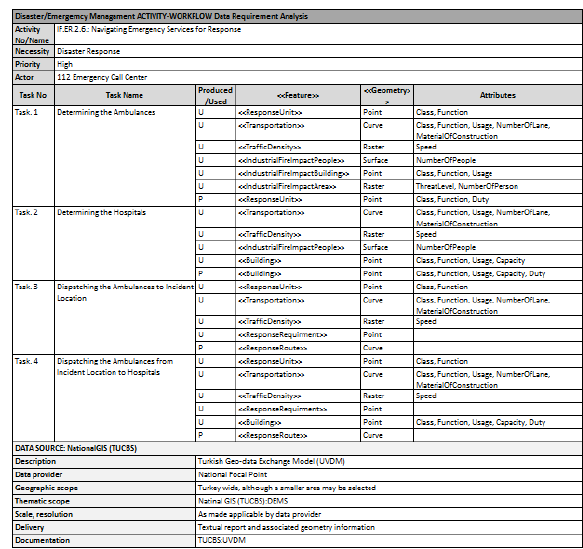
Table 3. Data requirement analyse for ‘Navigating Emergency Services for Response’